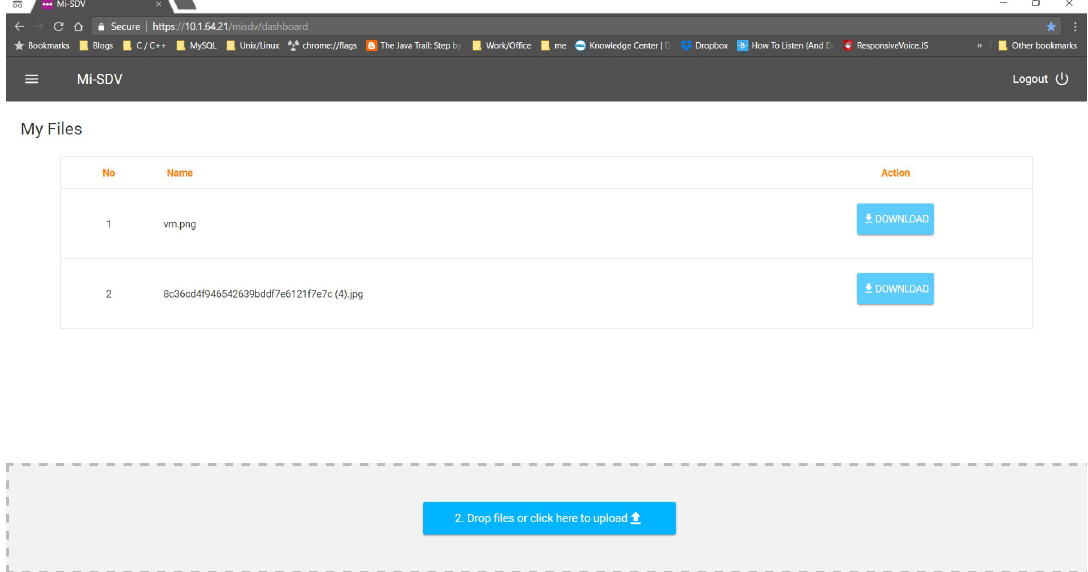
Figure 4. SDV dashboard: Document submission and